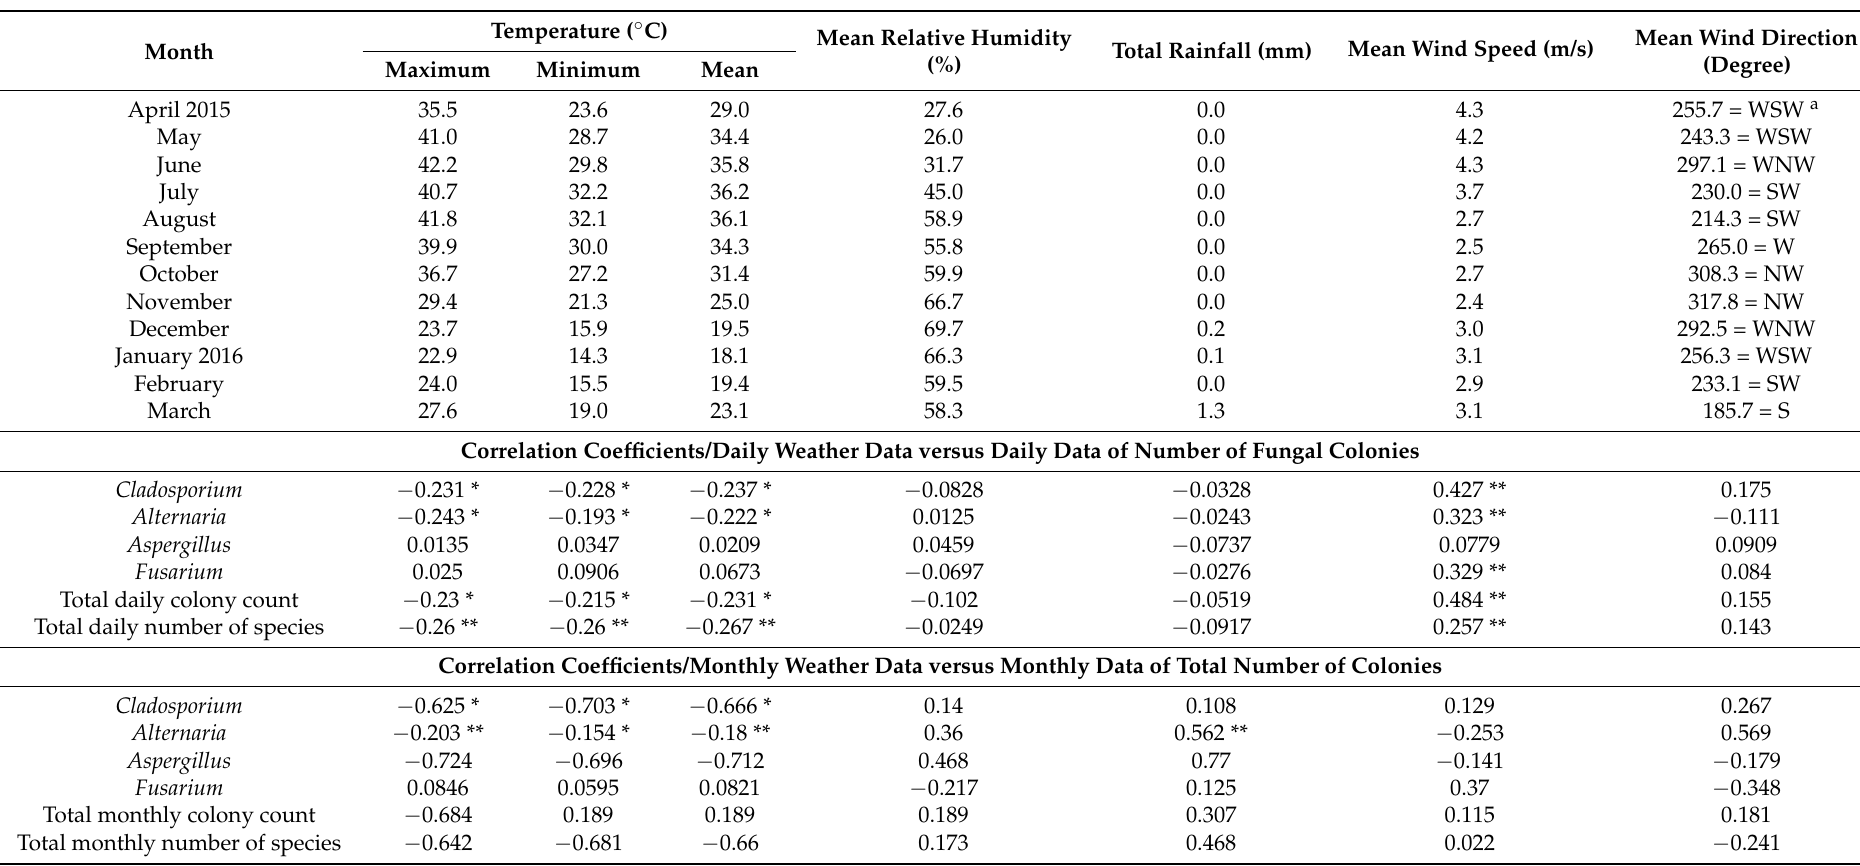
Table 2. Monthly climatic parameters of Doha during the year of study versus results of correlation analysis. The correlation was accomplished based on daily data as well as monthly data and using Pearson correlation